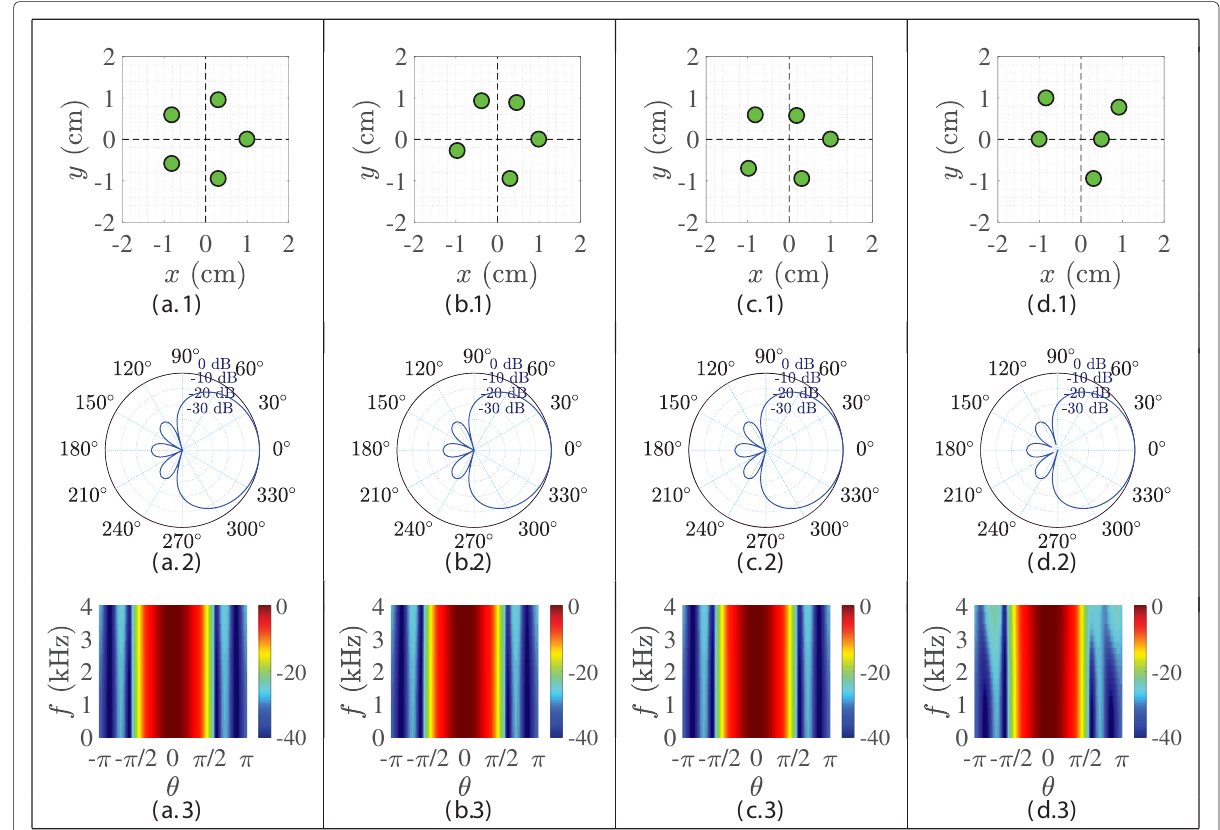
Fig. 2 Array geometries and the corresponding beampatterns of a first-order differential beamformer: a array geometry, b beampatterns at f = 500 Hz, and c broadband beampattern versus